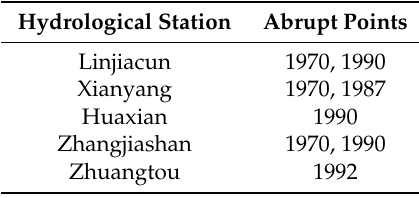
Table 4. Abrupt changes in the runoff series from 1960 to